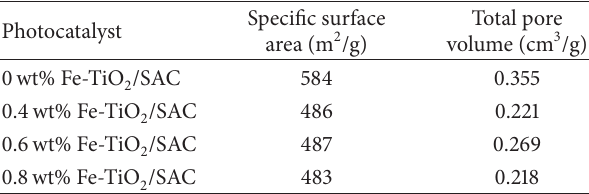
Table 1: Specific surface area and total pore volume of Fe-TiO with different Fe